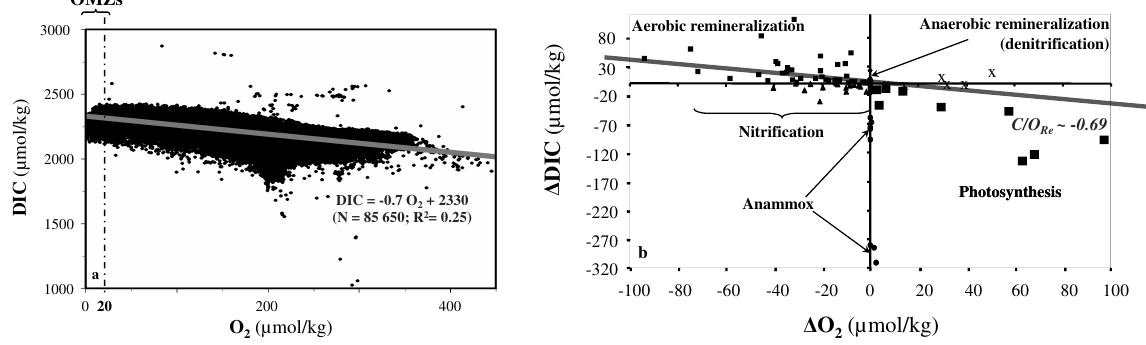
Fig. 5. (a) : DIC-O 2 diagram for the global ocean (all WOCE data with both DIC and O 2 available). (b) : 1 DIC- 1 O 2 diagram (from all stations sampled in the OMZ off Chile in 2000–2002, mainly focused in the oxycline). For (a) , the grey line corresponds to classical linear regression, with N = 85 650 data and a regression coefficient R 2 of 0.25: DIC = − 0 . 7 O 2 + 2330. For (b) , 1 DIC and 1 O 2 correspond to the biogeochemical contribution to DIC and O 2 , respectively, using an inverse method (cf. Methodology). Each symbol corresponds to one dominating biogeochemical process, which has been suggested and identified indirectly from theoretical chemical reactions: aerobic reminer- alization (small squares); nitrification (triangles); anaerobic remineralization (diamonds, mainly near 1 DIC- 1 O 2 ≈ (0,0)); photosynthesis (large squares); anammox (circles). Crosses correspond to non determined process. Accuracy and reproducibility on DIC and O 2 induce an uncertainty on the 1 of ∼ 4µmolkg − 1 (cf. Paulmier et al., 2006). (C/O) Re corresponds to the reference molar ratio for this study of 117/170 (Anderson and Sarmiento,